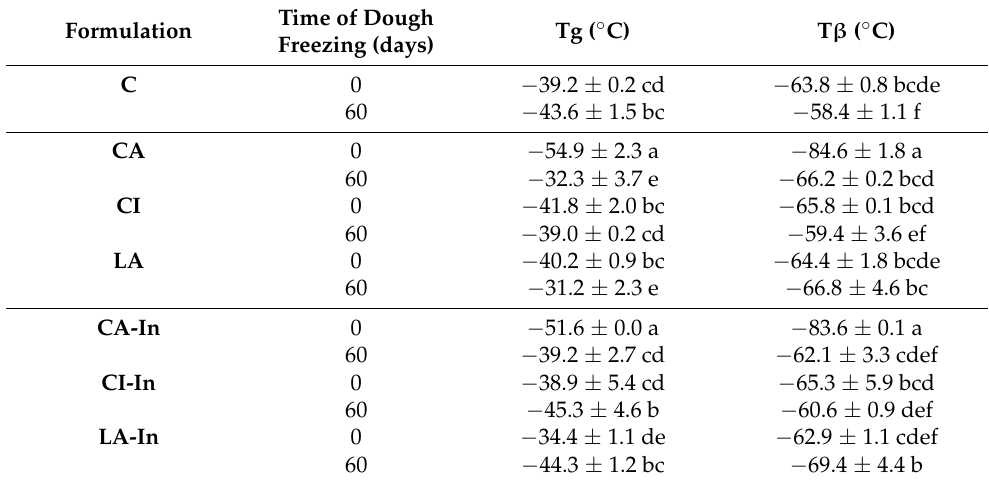
Different letters in the same column indicate statistical differences ( p <